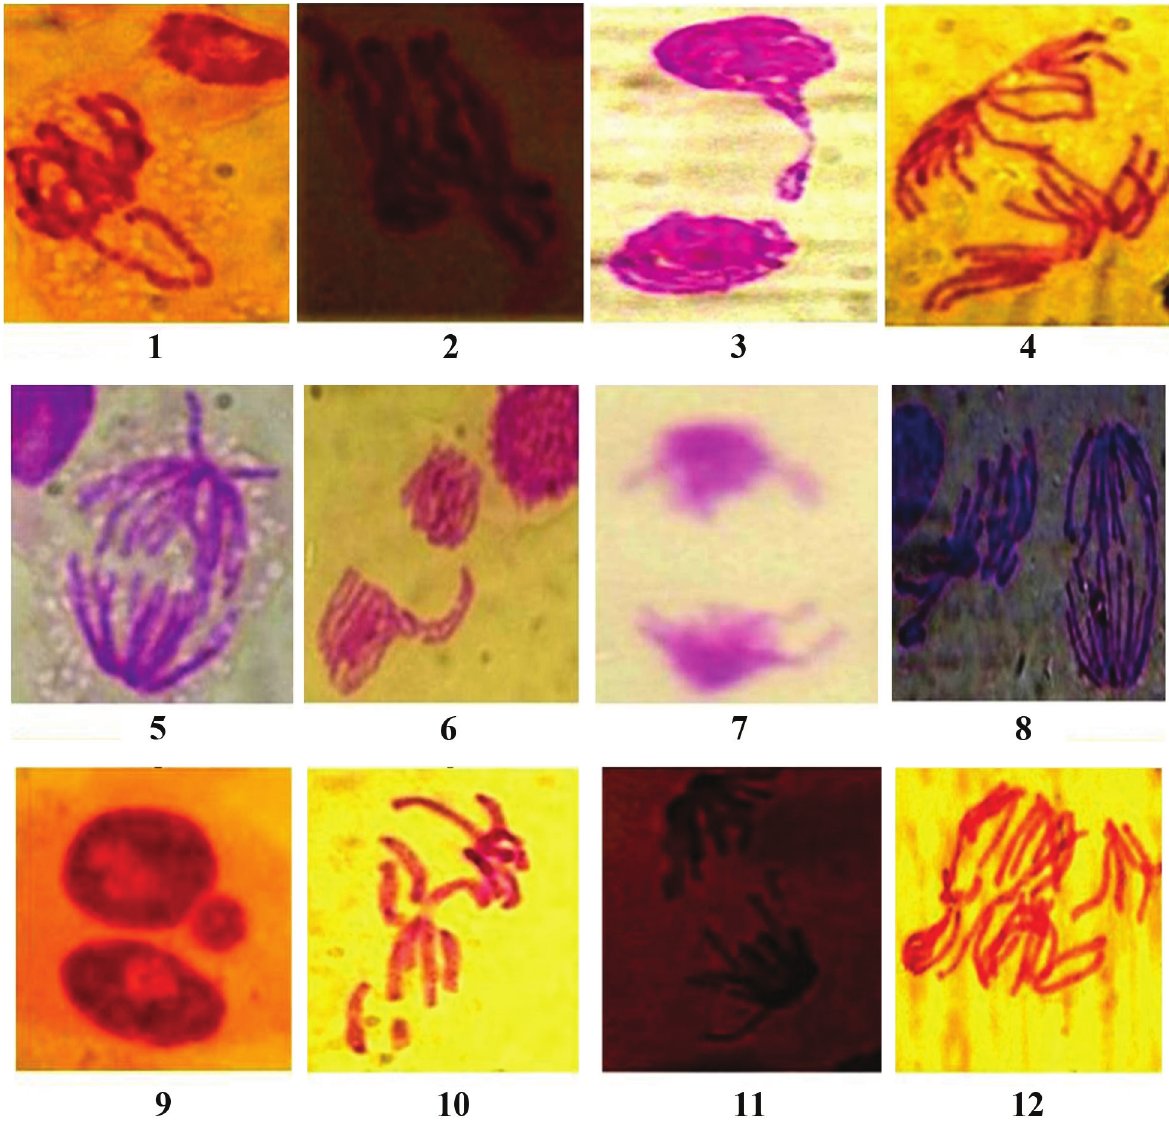
Figure 2 - Types of abnormalities in V. faba (Giza 3) root-tip meristems after root treatment for 6, 12 and 24 h with three extracts of D. glaucum Decne. 1. Sticky prophase with lagging chromosome, 2. Sticky metaphase, 3. Sticky telophase with broken bridge, 4. Sticky anaphase with broken bridge, 5. Anaphase with bridge and forward chromosome, 6. Sticky anaphase, 7. Anaphase with bridge, 8. Unseparated anaphase, 9. Micronuclei, 10. Disturbed anaphase with fragment and laggard chromosome, 11. Anaphase with broken bridge and fragment, 12. Disturbed anaphase with lagging chromosome. (See the colors in the online